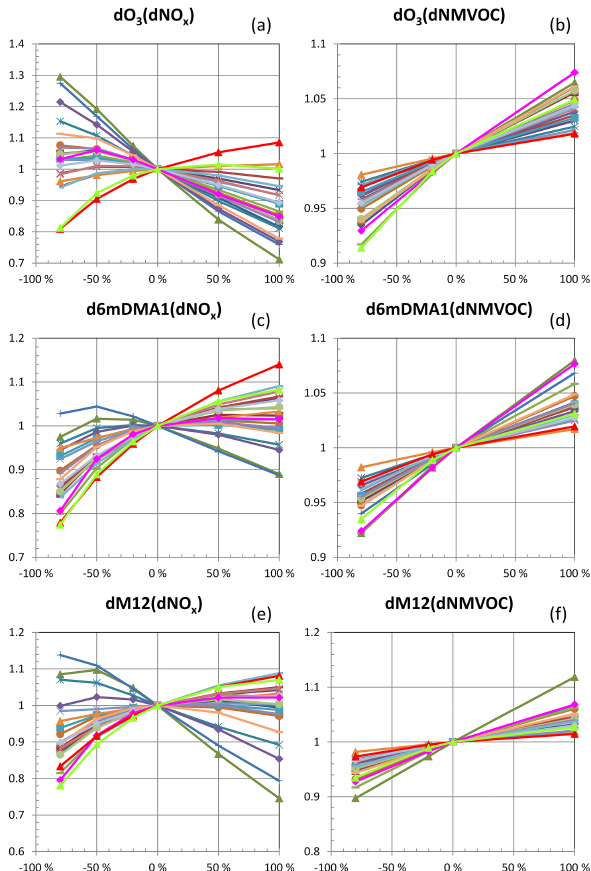
Figure 6. TM5 CTM response in population-weighted annual mean O 3 (a, b) , health exposure metric 6mDMA1 (c, d) , and in grid- cell-area-weighted crop exposure metric M12 (e, f) relative to their respective base simulation values, as a function of precursors NO x (a, c, e) and NMVOC (b, d, f) emission perturbation strength. Legend as in Fig. 3. European regions are perturbed simultaneously.